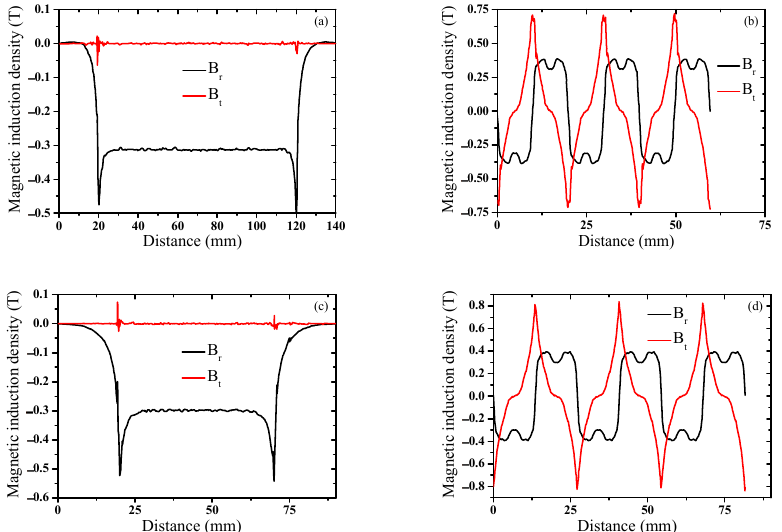
Figure 8. Magnetic field (T) at 60 ◦ rotating angle. ( a ) B r and B t along the z -axis of model 1; ( b ) B r and B t along the circle of model 1; ( c ) B r and B t along the z -axis of model 2; ( d ) B r and B t along the circle of model 2.